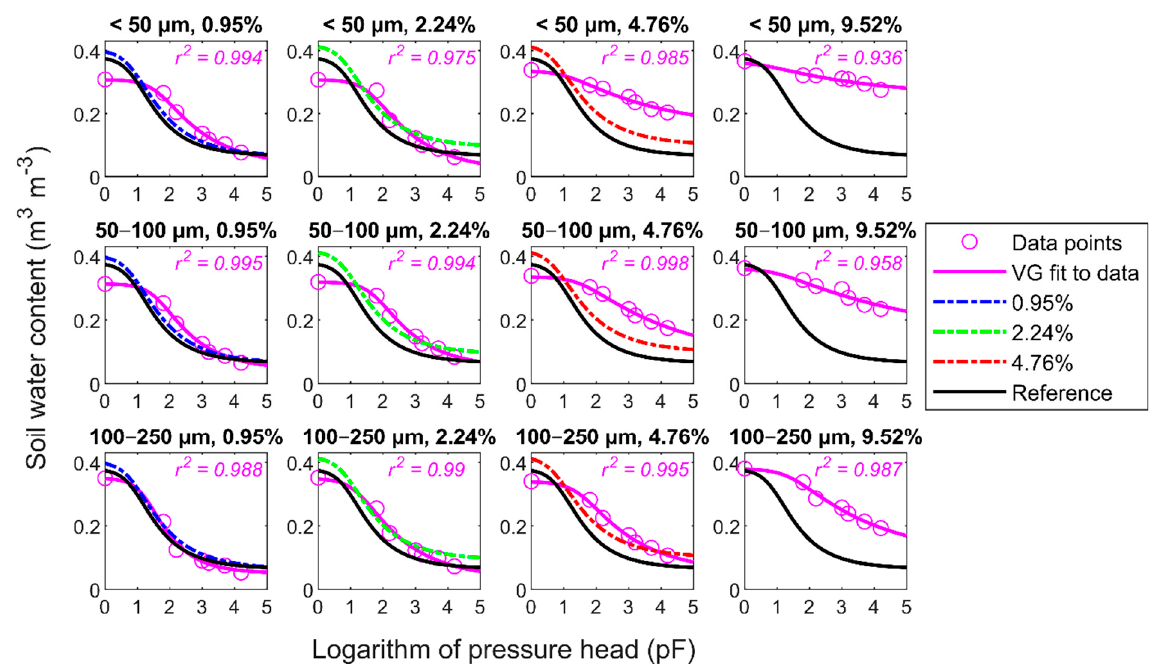
Figure 5. The water retention data for the fine fractions (<50 µ m, 50–100 µ m, and 100–250 µ m) and four doses (0.95, 2.24, 4.76, and additionally 9.52 wt.%) of biochar are shown together with the van Genuchten (VG) function fit (both in magenta) as circles and solid lines, respectively. The quality of the fits is characterised by the coefficient of determination ( r 2 ). The datasets are compared with the VG fit results for the corresponding doses of the sieved biochar ( φ < 2000 µ m—apart from the 9.52 wt.% content, for which the samples with sieved biochar were not measured) and the unamended reference data.